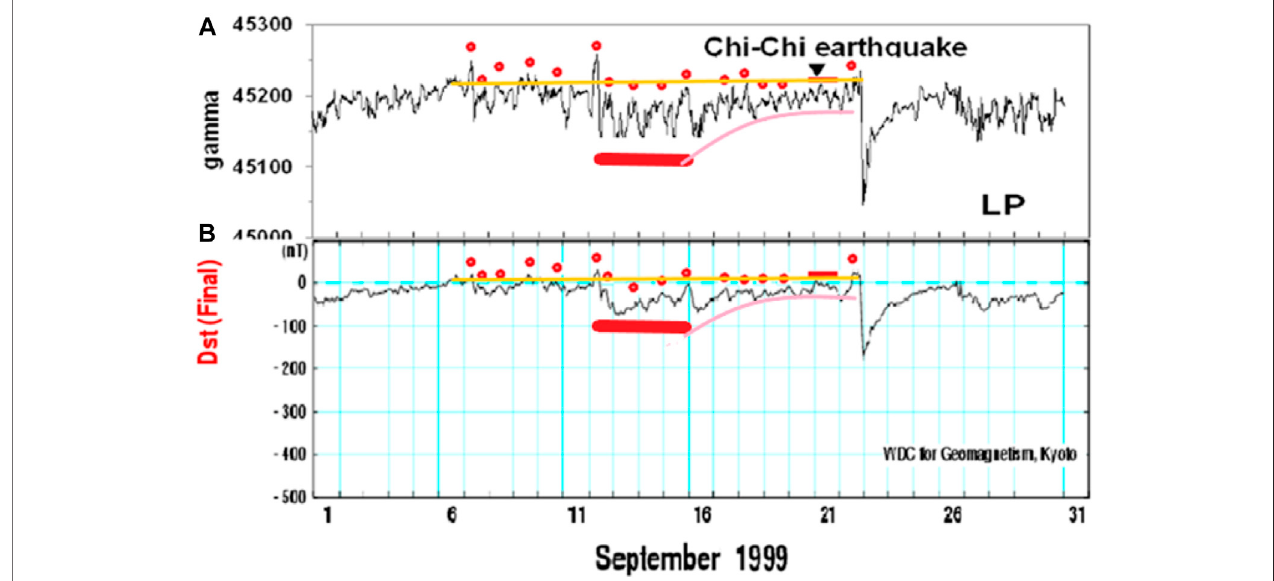
FIGURE 2 | Local magnetic fi eld B at LP observatory, Taiwan (top panel) along with the Global Dst index of the geomagnetic storm activity in September 1999, includingthetimeofthecatastrophicChi-Chi,1999earthquake.Itisobviousthatthetwopro fi lesaresimilar (A,B) duringalmostallSeptember,andenhanced fl uctuation occurs almost simultaneously in (B) and Dst values, during a general decrease in both pro fi les, before the time of the Chi-Chi earthquake (black arrow in (A) . The pre- earthquake magnetic pro fi le in Taiwan obviously re fl ects the geomagnetic storm activity as indicated by the index Dst (see in the text).